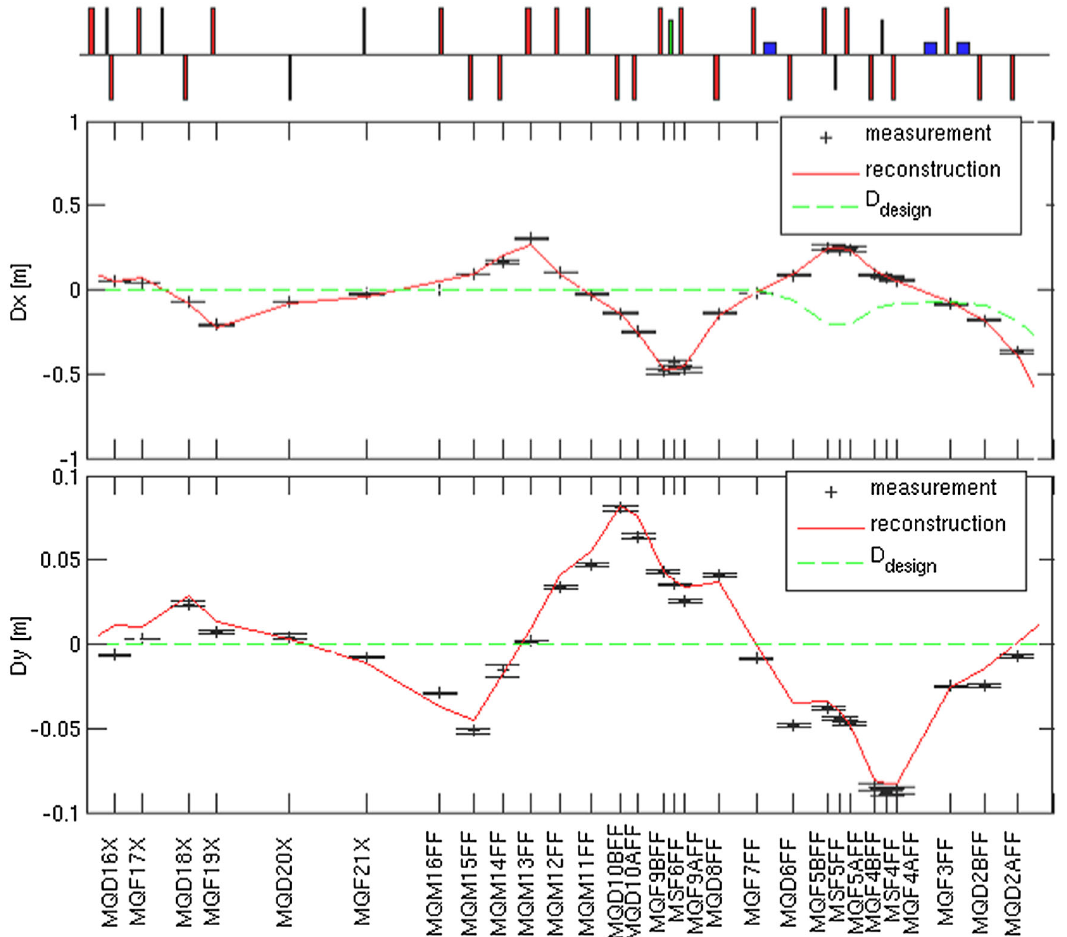
FIG. 7. Reconstructed dispersion compared to individual BPM measurements based on changing the